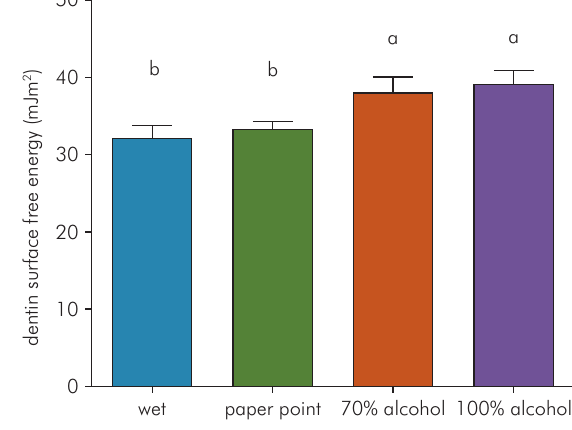
Figure 3. Dentin surface physicochemical properties and interaction with AH Plus. Dentin surface free energy.